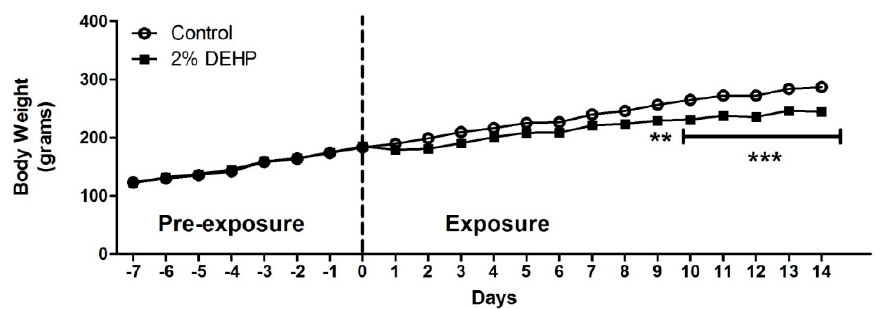
Figure 3. Effects of 2% DEHP exposure on body weights of male Wistar rats throughout the study duration (7 day pre-exposure and 14 day exposure) ( n = 7 per group). Significant differences are indicated with; ** p < 0.01 and *** p <